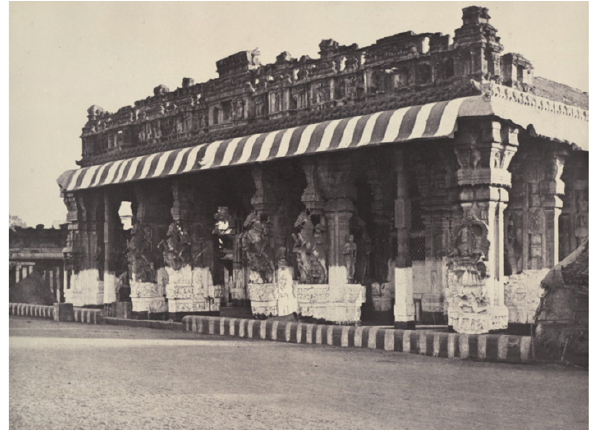
Figure 1. Pointcloud of the Minakshi Sundareshvara Temple, Madurai showing the Pudhu Mandapam from TLS (3 scans) made in 2018 looking East (West front indicated by the circle)